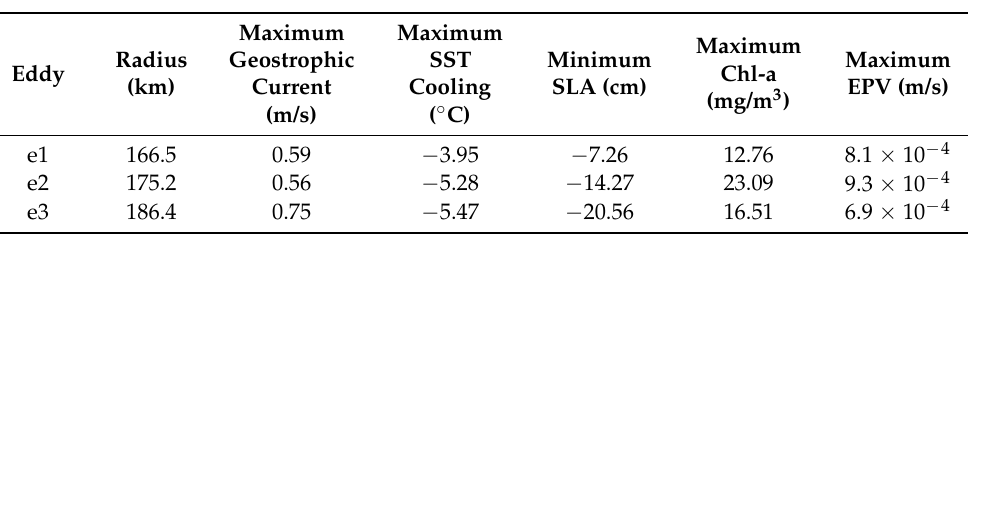
Figure 4. Daily variations in ( a ) EPV, ( b ) SST, ( c ) SLA, and ( d ) sea surface chl-a concentration along the tracks of the TC Kyarr from 1 October to 30 November. The contour lines represent integer EPV and SLA in ( a ) and ( d ), respectively. Time is divided by four black lines into five periods (Pre-TC: before 25 October; During Kyarr: 26 October to 30 October; Post Kyarr: 1 November to 2 November; During Maha: 2 November to 5 November; Post Maha: after 5 November).